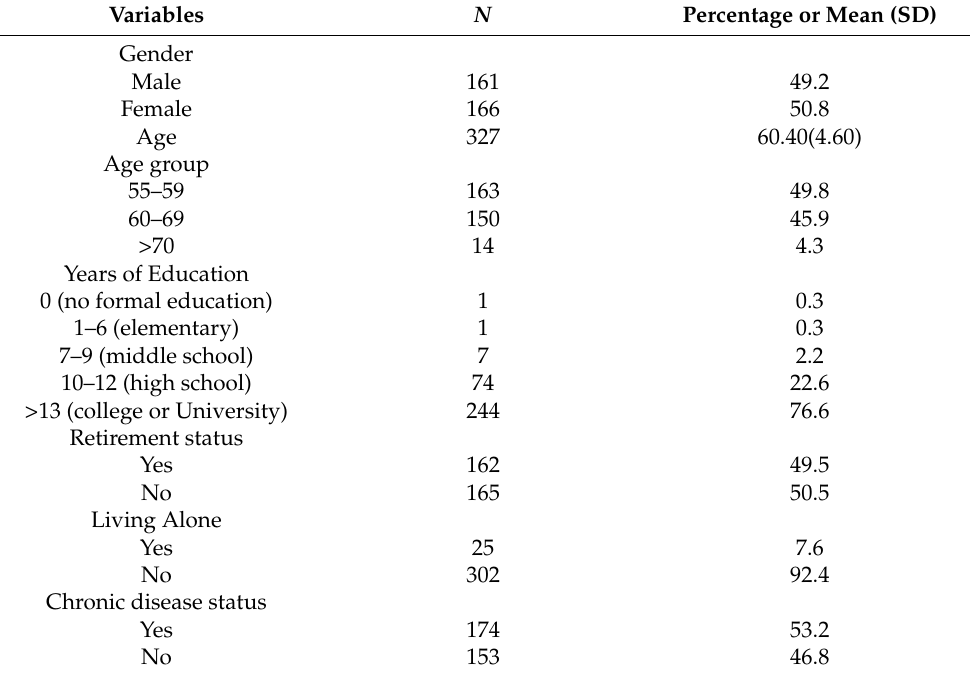
Table 1. General characteristics of the study participants ( n =